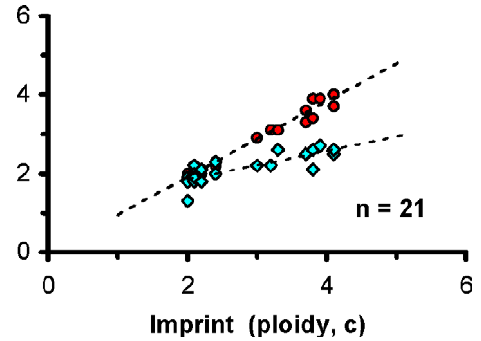
Fig. 1. Feulgen DNA from interphase nuclei in 8 µ m ( " ) and 4 µ m ( F ) sections, each compared with replica imprints. Mean ploidy of 150 nuclei was recorded from 21 breast cancers.